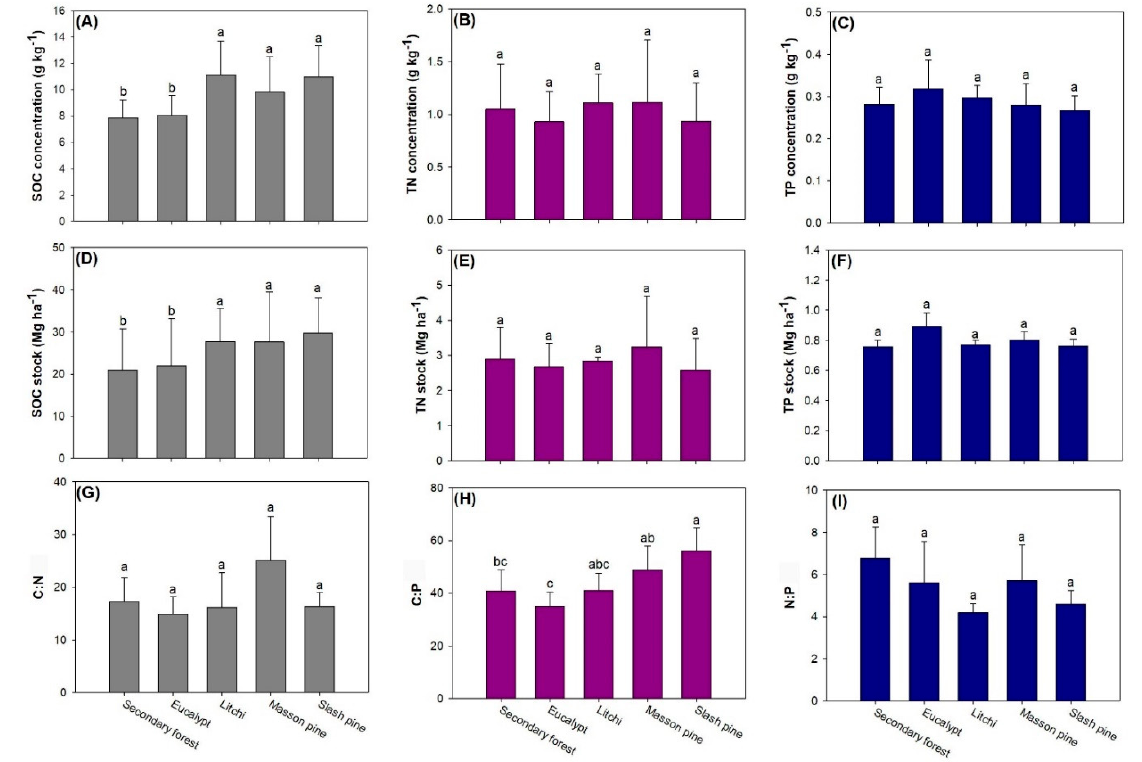
Figure 2. Differences of soil organic carbon (SOC) ( A , D ), total nitrogen (TN) ( B , E ), and total phosphorus (TP) ( C , F ) and ratios of C:N ( G ), C:P ( H ), and (N:P) ( I ) in secondary forests and four types of plantations of Eucalypt ( Eucalyptus obliqua L’Hér.), Litchi ( Litchi chinensis Sonn., 1782), Masson pine ( Pinus massoniana Lamb.), and Slash pine ( Pinus elliottii Engelm.) in Yunfu, Guangdong province, South China. Bars indicate standard deviations. Different letters over bars indicate significant difference detected by Duncan test at 0.05 level.